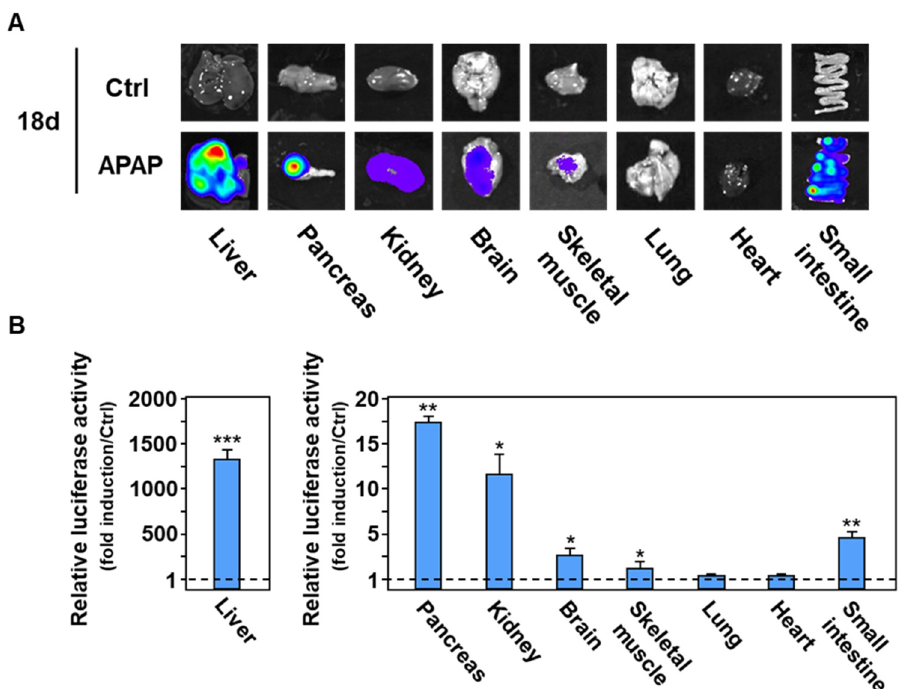
Figure 2. Identification of the eIF2 α -ATF4 pathway target tissues in response to 18 d of APAP treatment. ( A ) Visualization of bioluminescence by imaging several organs. CARE-LUC mice were fed the Crtl diet (Ctrl) or the APAP diet (APAP) for 18 d. After bioluminescence imaging, mice were sacrificed by cervical dislocation, organs were rapidly excised and imaged, followed by snap-freezing of the organ for subsequent luciferase enzyme assay. ( B ) Luciferase activity measured in tissue extracts. Results are given as fold induction in APAP group relative to Ctrl group. The graphs show means ± S.E.M. of 6 mice. * p ≤ 0.05; ** p ≤ 0.01; *** p ≤ 0.001 compared to the respective Ctrl value, Student’s t -test.